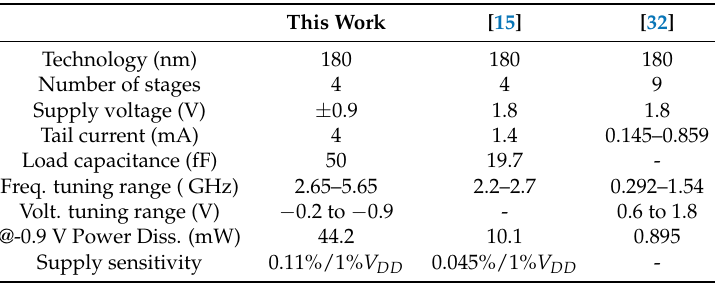
Figure 11. VCO’s oscillation frequency vs. supply voltage. Table 3. Comparison among the proposed VCO and related designs.